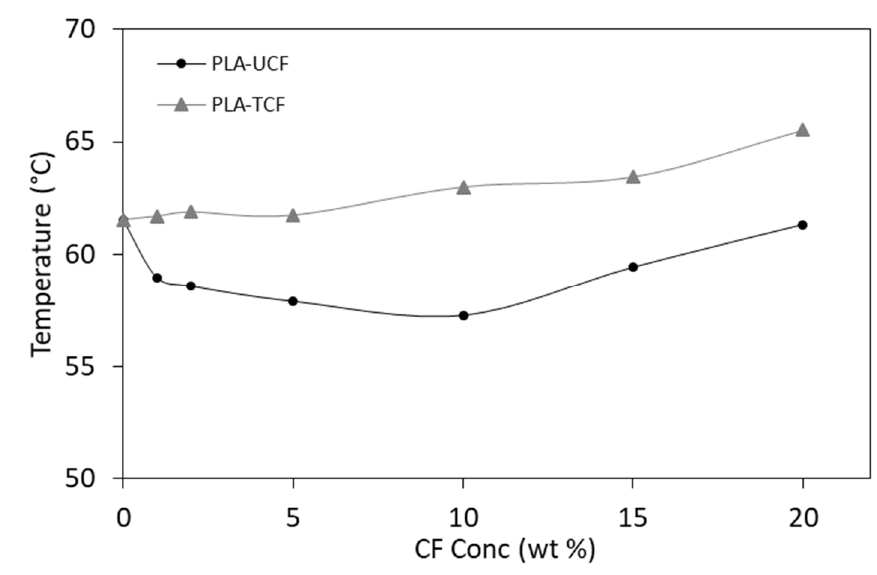
Figure 9. Glass transition temperature of films with varying CF concentration.